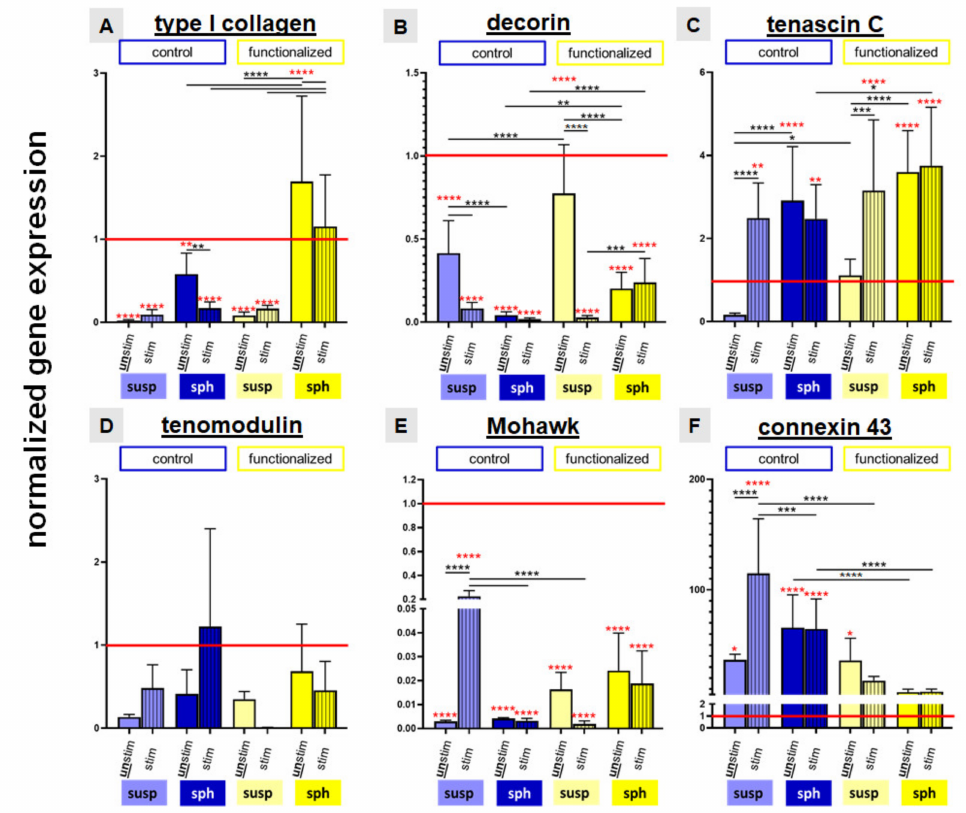
Figure 8. Normalized gene expression of ligament associated matrix components like type I collagen ( A ), decorin ( B ), tenascin C ( C ), the transcription factors tenomodulin ( D ) and Mohawk ( E ) and connexin 43 ( F ). Control scaffolds (blue) and functionalized scaffolds (yellow) were pre-colonized with suspension (susp: dynamically pre-cultured for 24 h) or spheroid (sph: statically pre-cultured for 5 days) culture. Unstimulated (unstim, full bars) and stimulated (stim, striped bars) scaffolds were compared to the native lapine anterior cruciate ligament (LACL, red line) and shown as mean with SEM. Three independent experiments with cells of three different donors were performed. One-way ANOVA test with Tukey post hoc test showed significant differences with (*) p ≤ 0.05; (**) p ≤ 0.01; (***) p ≤ 0.0005; (****) p ≤ 0.0001. Red stars indicated the significant differences in comparison to the native